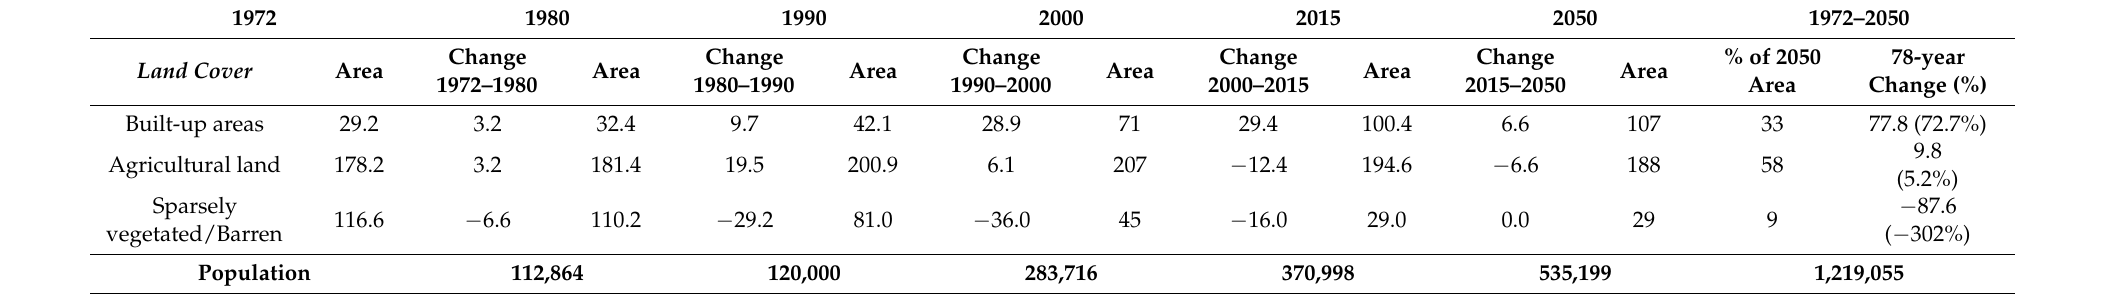
Table 5. Land cover changes across the study period from 1972 to 2050, in km 2